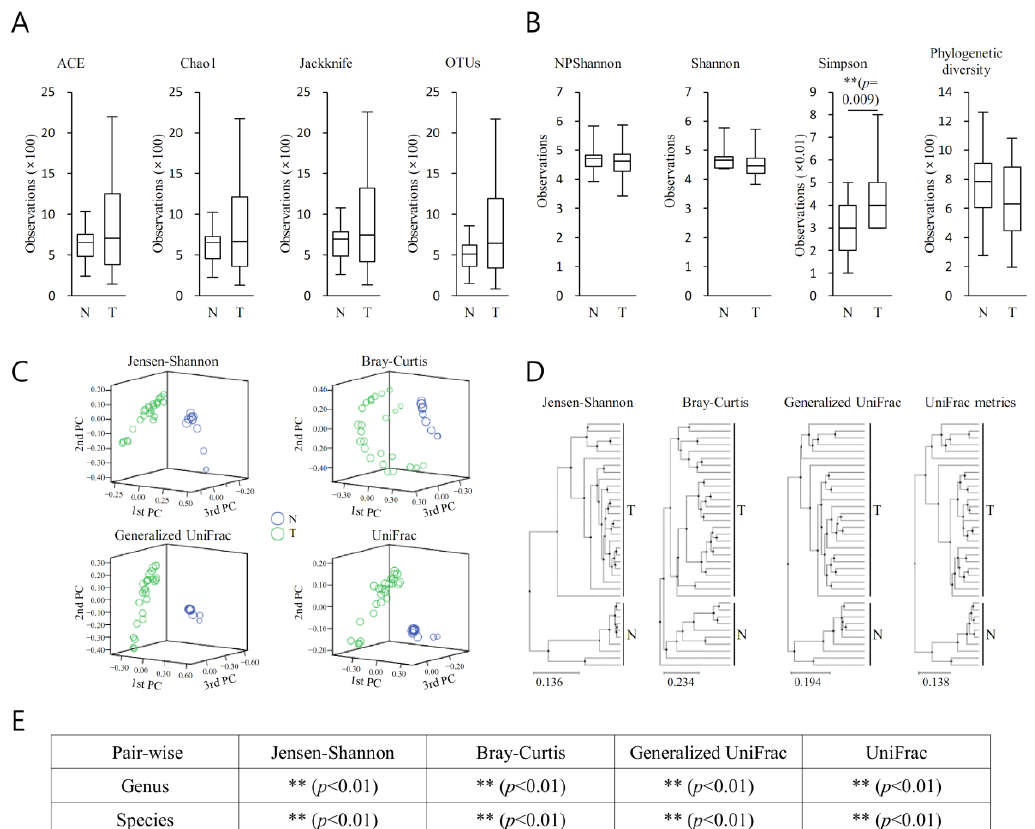
Figure 4. Alpha and beta diversity indices for benign prostatic tissue (BPH (N)) and tumour region in prostate cancer patients (MT(T)). ( A ) Species richness was analyzed with Ace, Chao1, Jackknife, and OTUs, ( B ) and the species diversity was analyzed with NPShannon, Shannon, Simpson, and phylogenetic diversity. The horizontal thick black band represents the median value, and the boxplot margins indicate first and third quartiles. ( C ) Distances between communities were analysed by a principal coordinate analysis (PCoA). ( D ) Clustering using the unweighted pair group method with arithmetic mean (UPGMA) was analysed. ( E ) Beta set-significance was demonstrated by permutational multivariate analysis of variance (PERMANOVA). Beta diversity analysis was performed using Jensen – Shannon, Bray – Curtis, Generalized UniFrac, and UniFrac metrics. Significance between the groups was mentioned as ** p < 0.01.